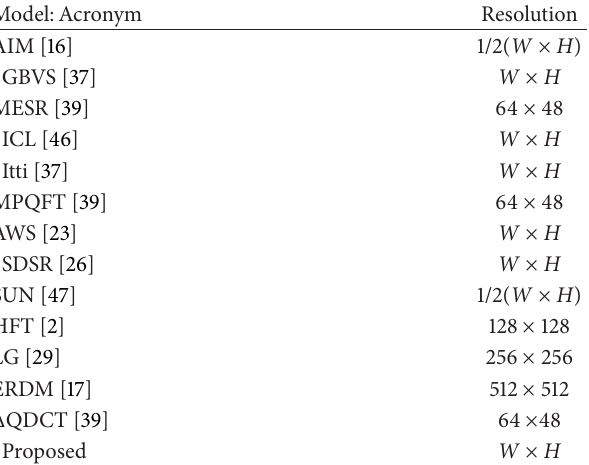
Table 1: Following are the input image resolution used in each algorithm with default parameter settings. Some algorithms (at least ∗ ) do internally reduce dimensions for fast computation and optimal